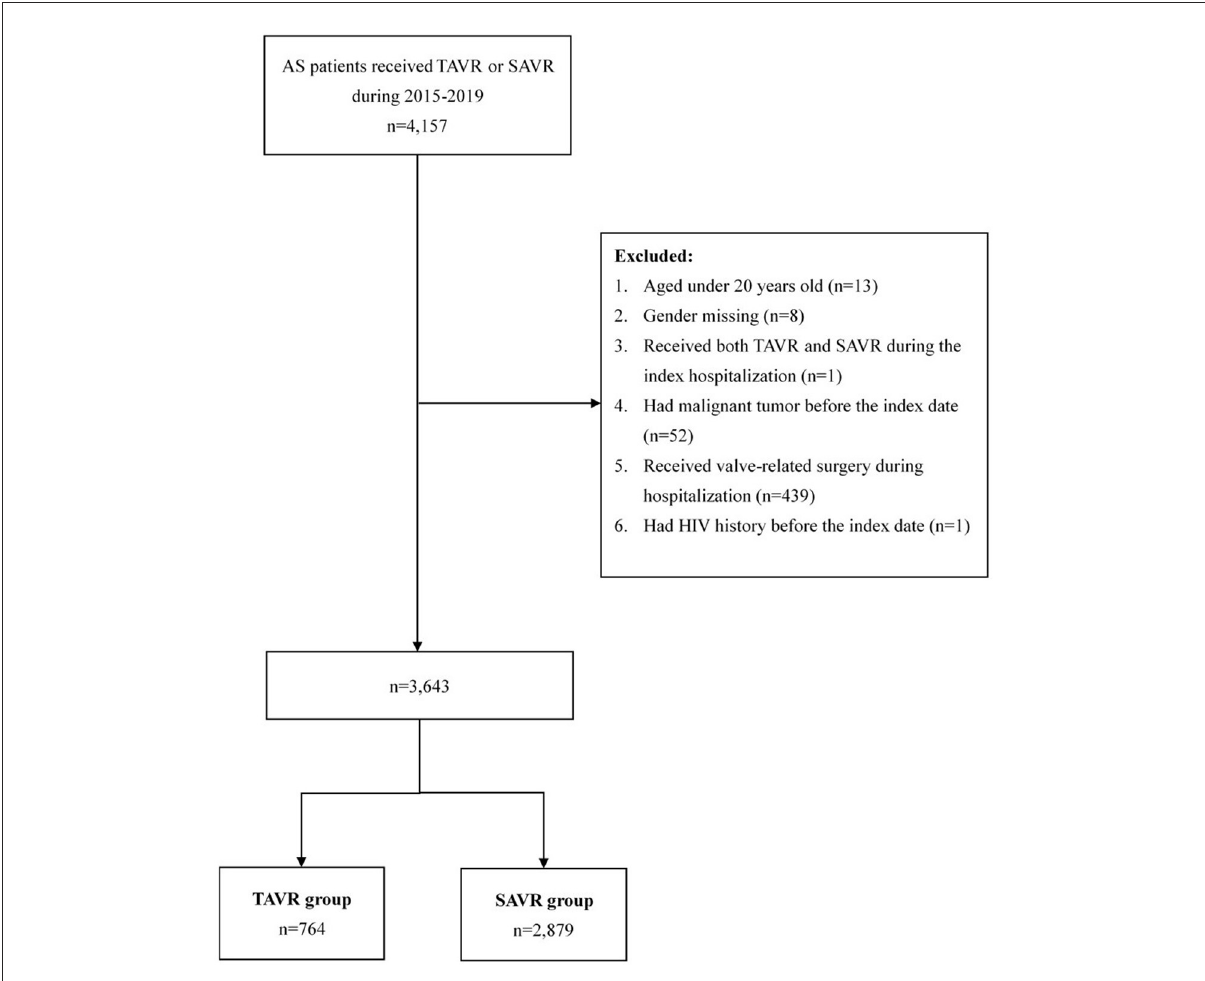
FIGURE1 Study Flow. Patient selection in the current